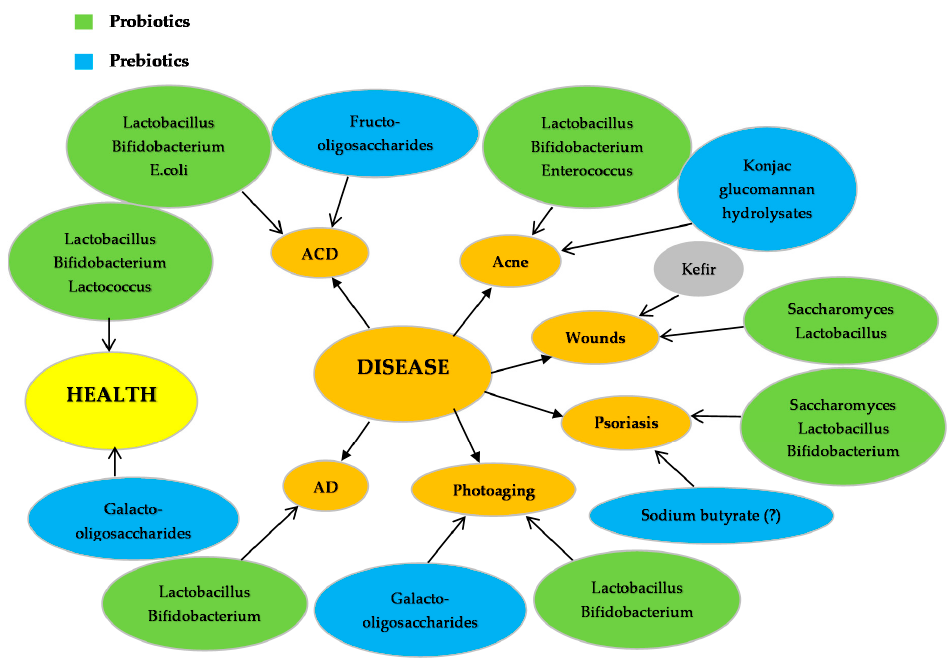
Figure 1. The role of probiotics and prebiotics on skin health and disease including Allergic Contact 54 Dermatitis (ACD), Acne, Wounds, Psoriasis, Photoaging and Atopic Dermatitis (AD). 55 Dermatitis (ACD), Acne, Wounds, Psoriasis, Photoaging and Atopic Dermatitis